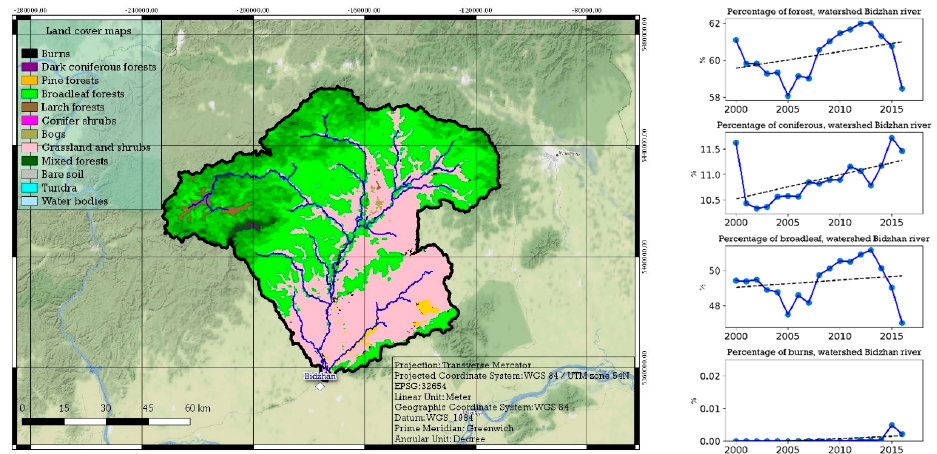
Figure A4. Vegetation dynamics of Bidzhan River watershed. Stream gaging is marked with the white diamond.